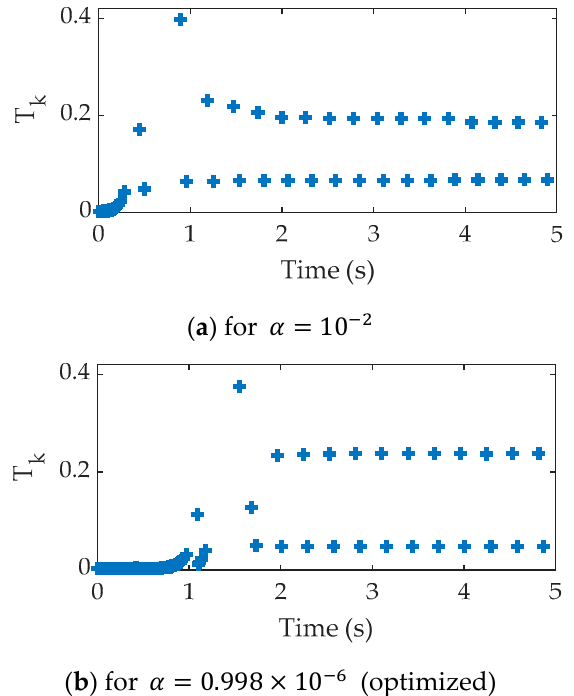
Figure 5. Inter event execution time, T k .